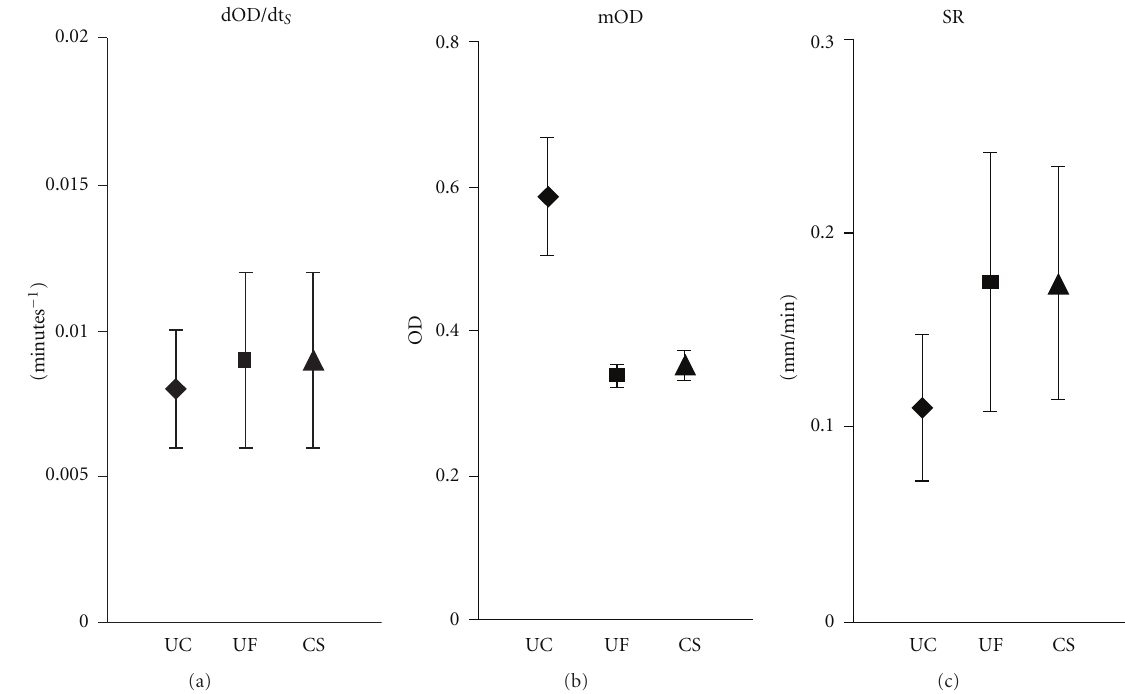
Figure 4: Slow OD decrease (dOD/dt S ), maximal optical density (mOD), and sedimentation rate of single crystals (SRs) in urine of controls (UCs), in ultrafiltrate of the same urine (UF), and in control solution (CS), mean ±